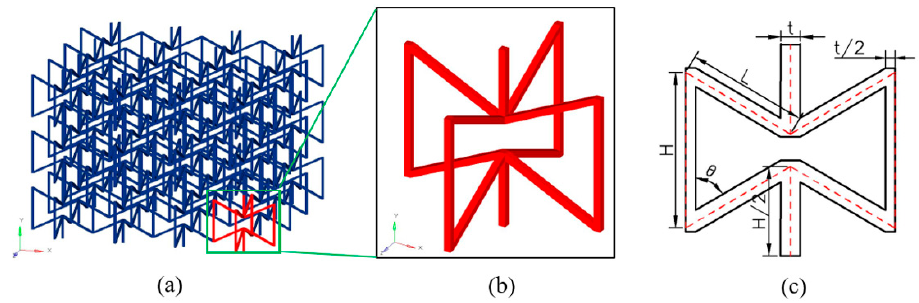
Figure 1. ( a ) 3D re-entrant auxetic cellular structure; ( b ) Representative volume element (RVE); ( c ) Geometrical features of the